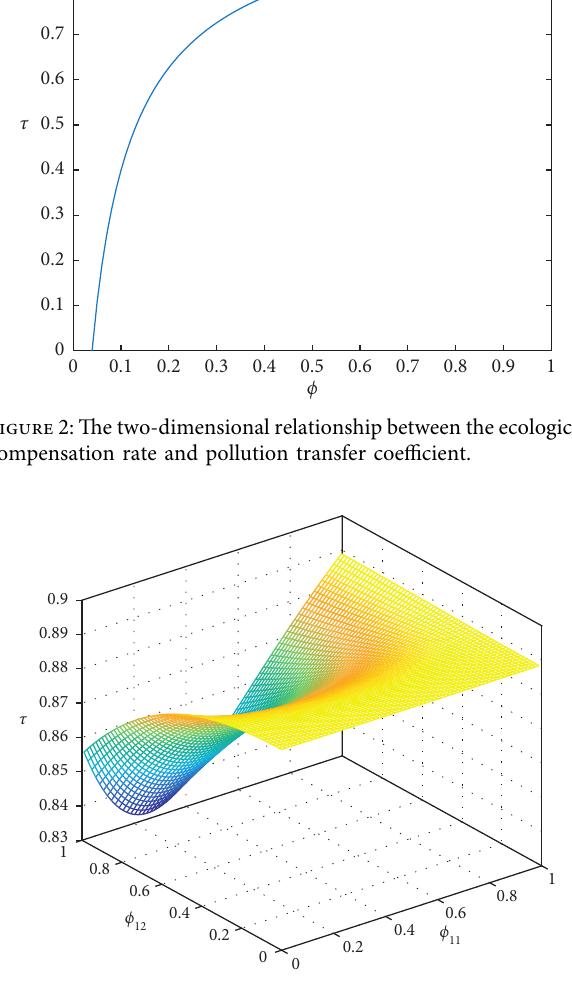
Figure 3: The three-dimensional relationship between ecological compensation rate and transfer coefficients of two